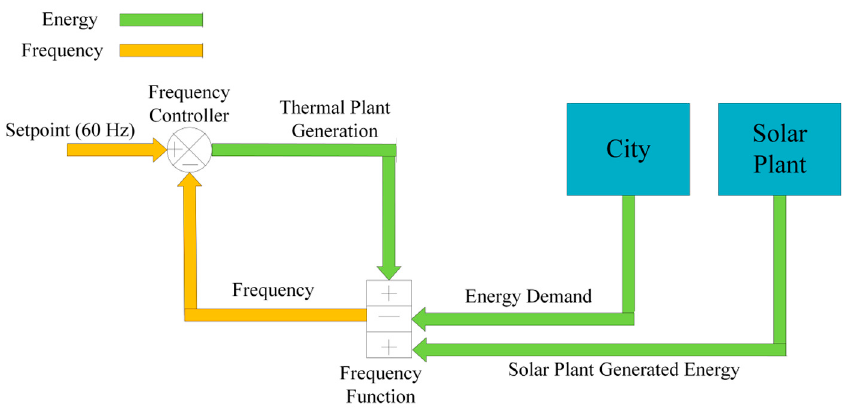
Figure 2. Grid operation flowchart.